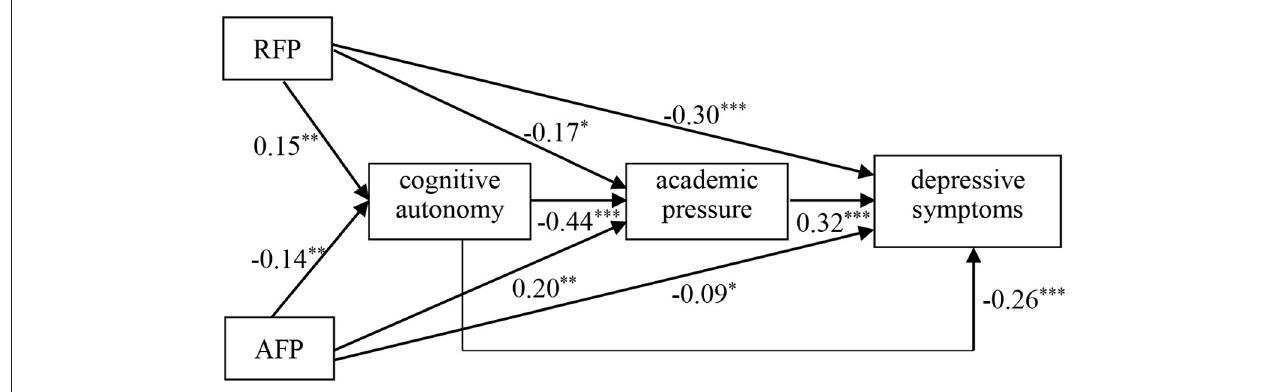
FIGURE 1 | The prediction of filial piety and cognitive autonomy to adolescents’ depressive symptoms. * p < 0.05. ** p < 0.01. *** p < 0.001.